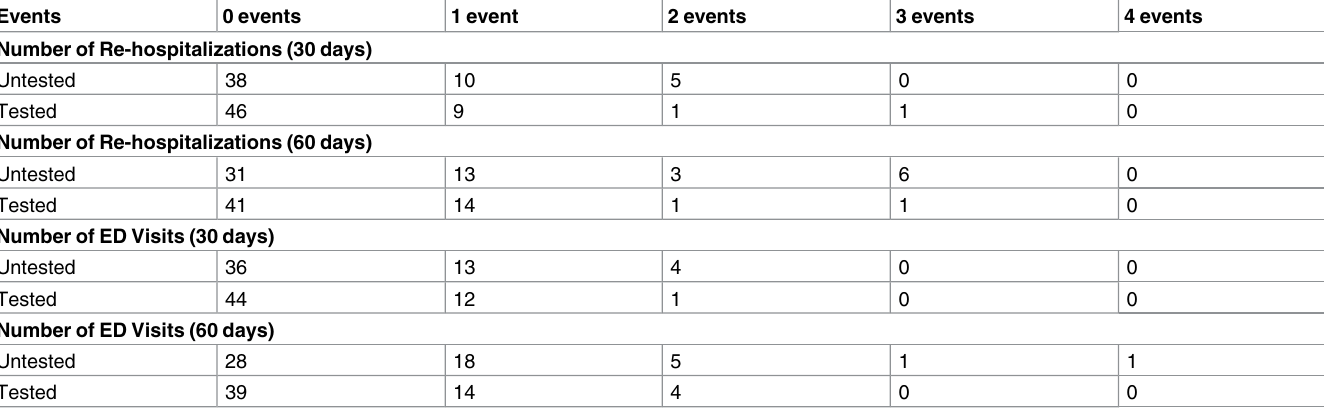
Table 2. The number of patients by the number of events for each primary outcome, by the treatment group.